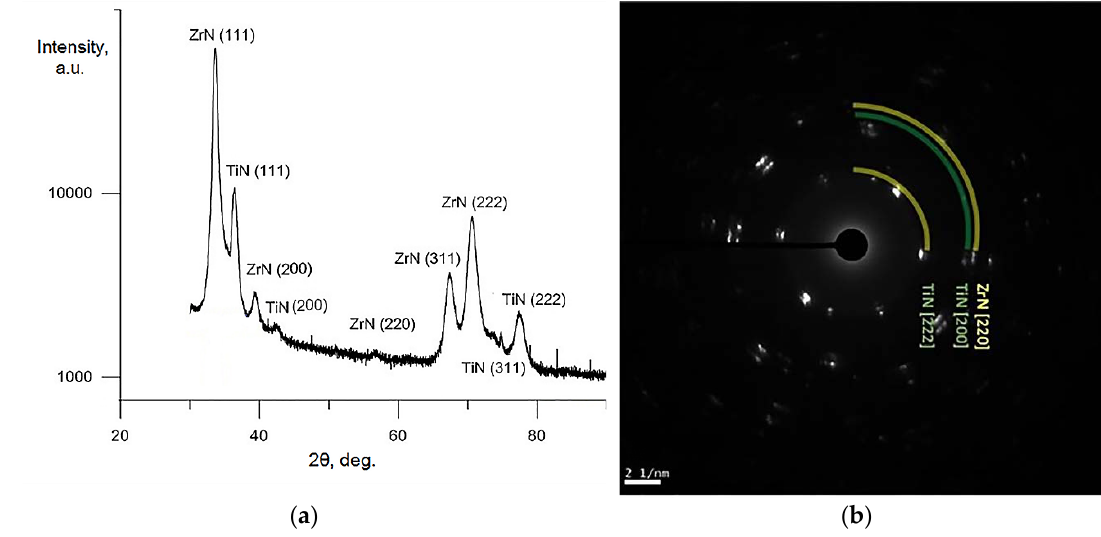
Figure 8. ( a ) X-ray diffraction (XRD) spectrum and ( b ) Selected area electron diffraction (SAED) image of TiN/ZrN multilayer coatings ( U b = −200 V, Λ = 39 nm). Reprinted with permission from [99] 2017 Elsevier.